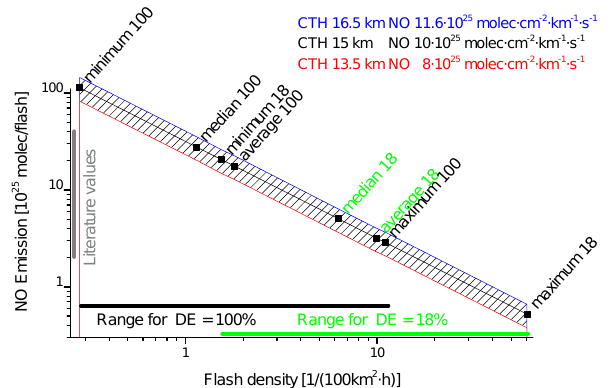
Figure 7. NO emissions per flash, depending on the flash den- sity and the CTH. The hashed area indicates the uncertainty due to different CTHs and NO emissions. The emissions necessary to explain our observations vary between 0 . 4 and 141 × 10 25 NO molecflash − 1 . However, these extreme values are retrieved using the minimum and the maximum flash density and assuming a DE of 100% for the minimum flash